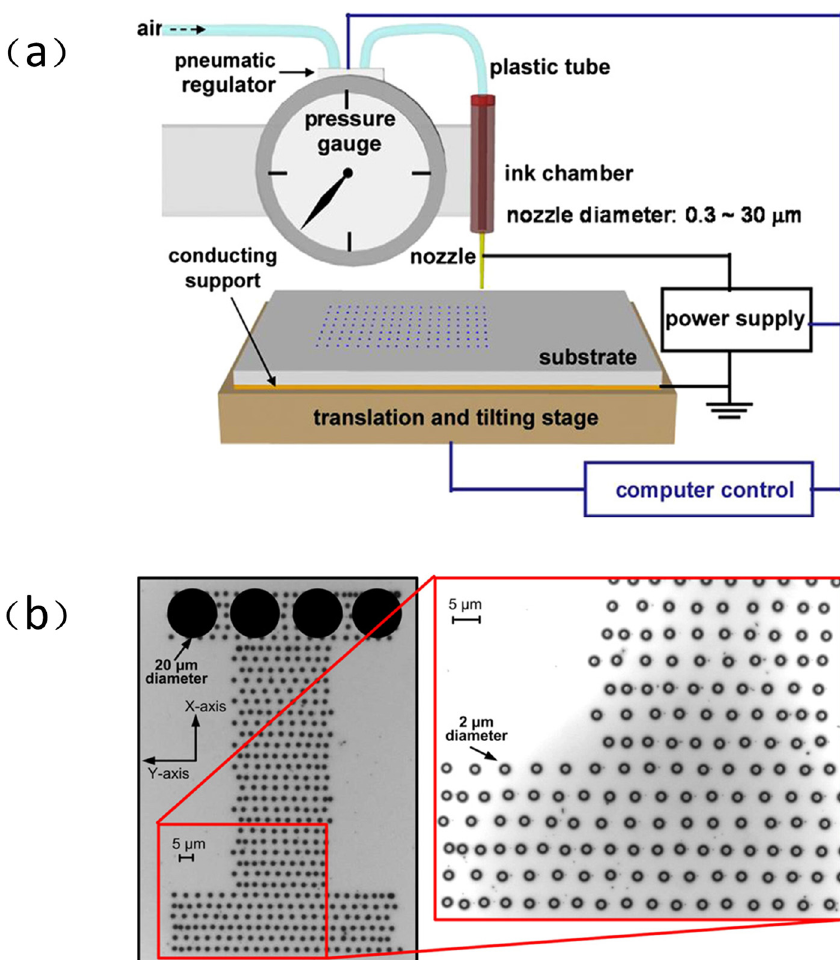
Figure 1: ( a ) The composition diagram of the electro fl uidic power jet printing system. ( b ) A droplet pattern array with an average diameter of 2.8 μ m printed by the E - jet printing system. Reproduced from ref. [ 37 ] with permission from Elsevier